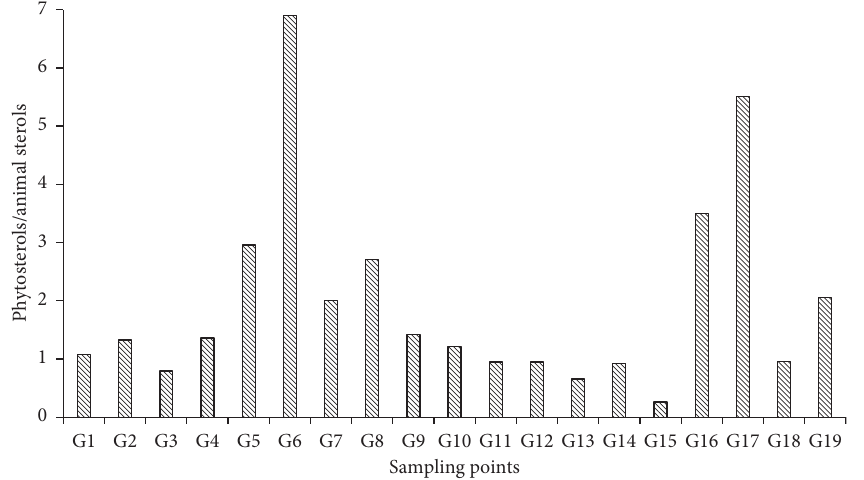
Figure 3: Ratios of phytosterols to animal sterols in sediments of the Guanting Reservoir.